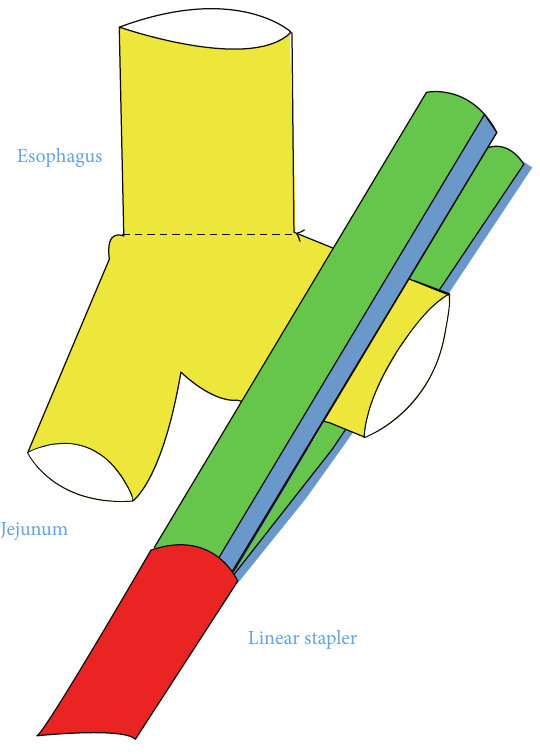
Figure 7: Illustration of the jejunal end closure.